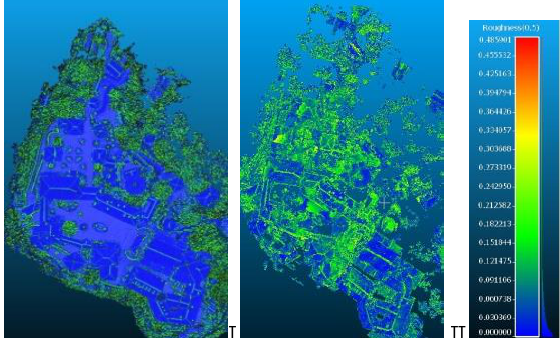
Figure 18 – Map of the discrepancies between the VisualSfM point cloud segment of a façade and the TLS point